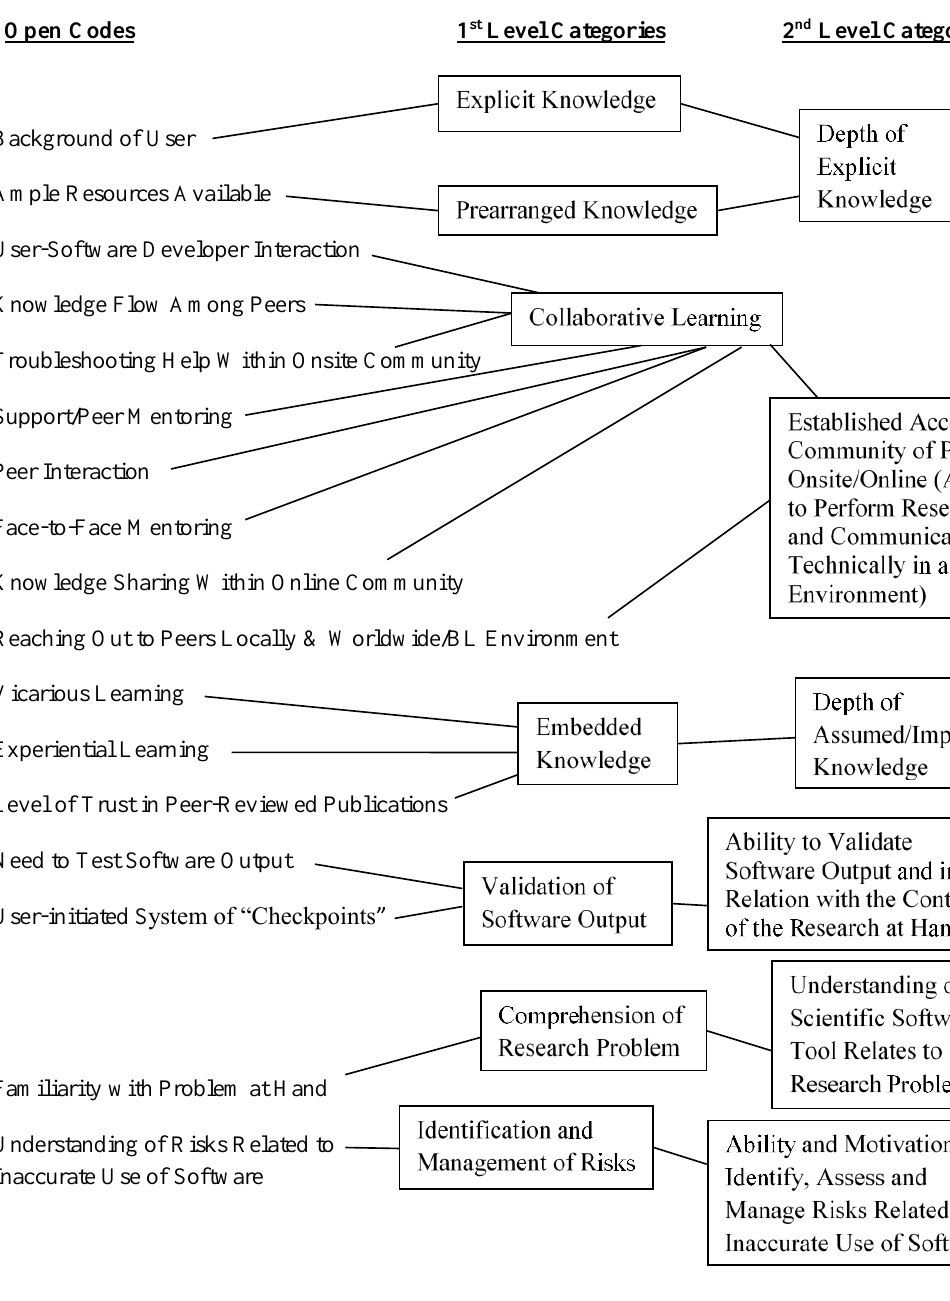
Figure 1. Example of coding scheme (Adapted from Mobilizing knowledge in science and engineering: Blended training for scientific software users (p. 66), by E. M. Skordaki, 2016, Athabasca, AB: Athabasca University. Copyright 2016 by Efrosyni-Maria